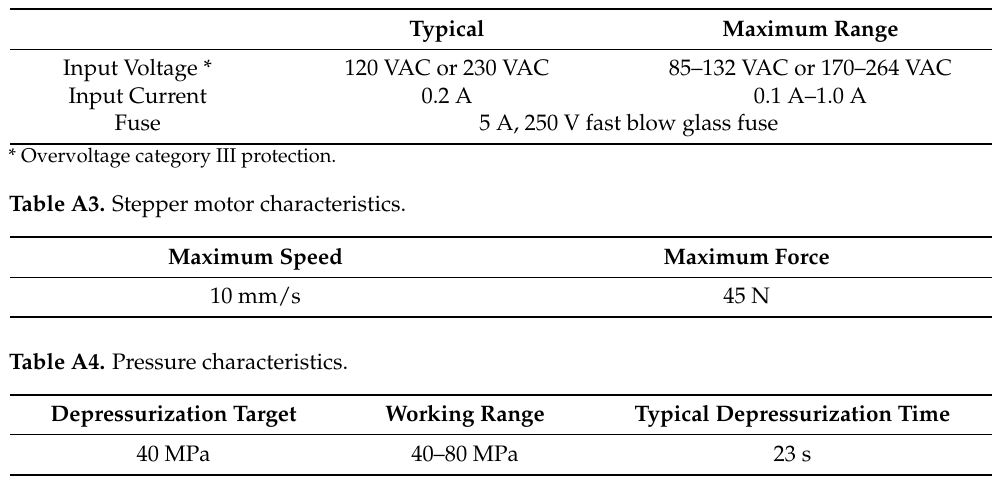
Table A2. Power supply characteristics.